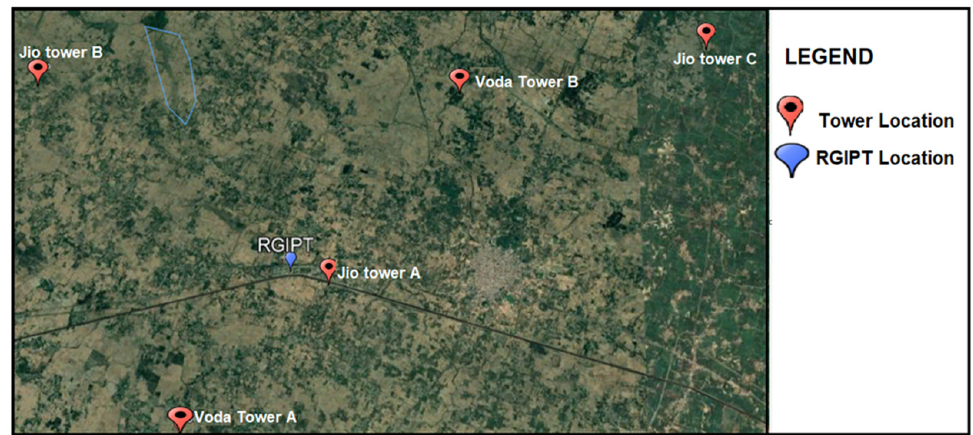
Figure 8. Tower locations near the RGIPT campus.